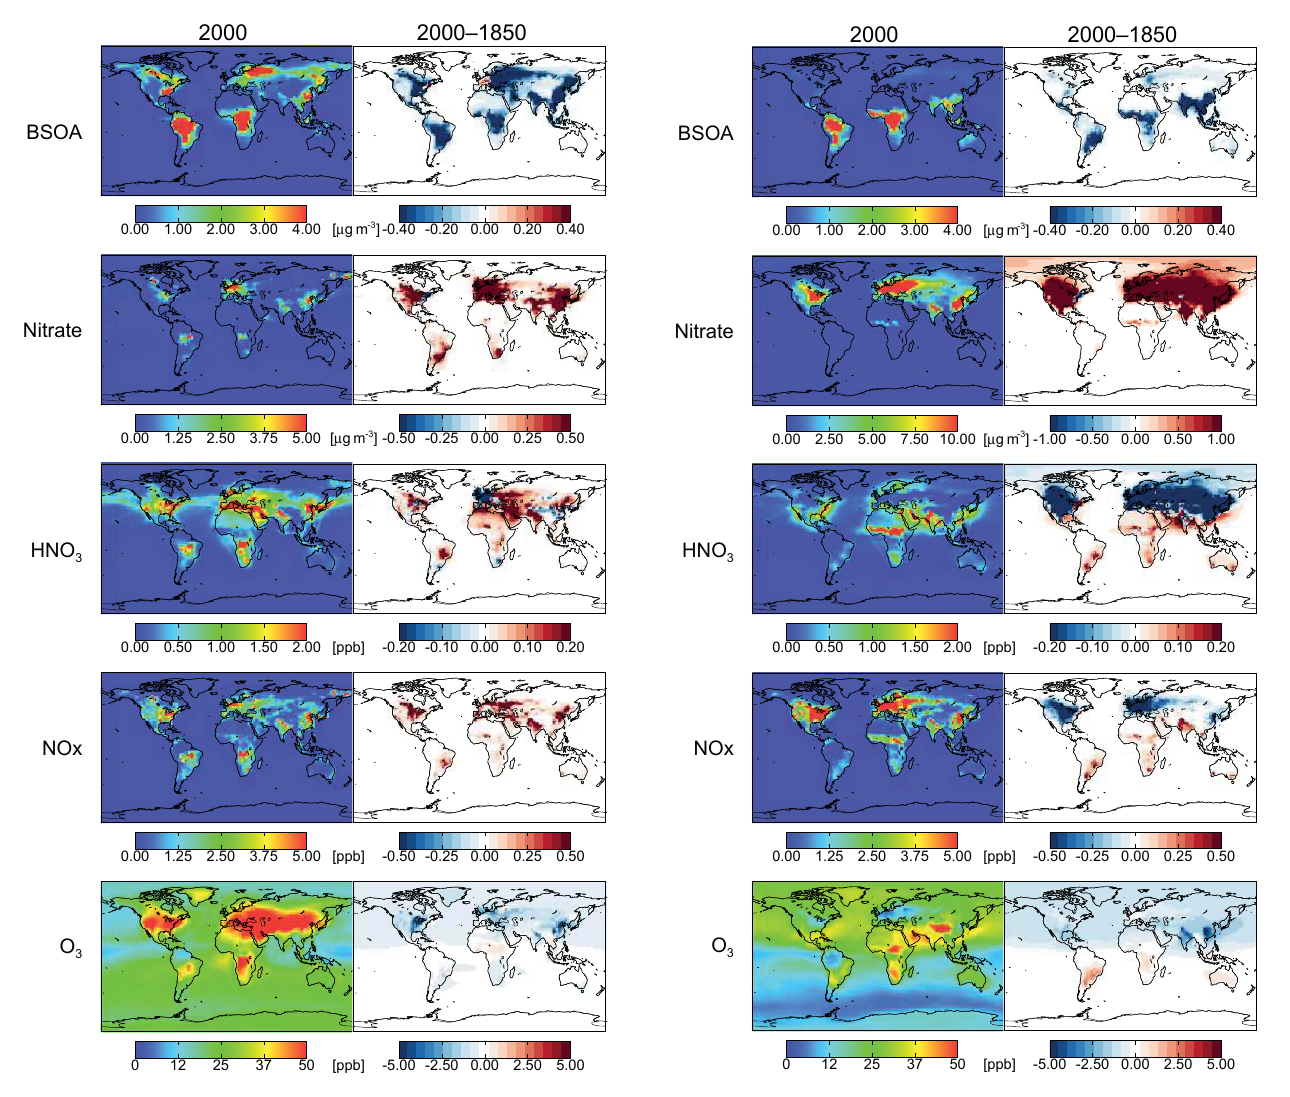
Figure 7. Boreal summertime (June–August) mean simulated sur- face concentrations of biogenic SOA (BSOA), aerosol nitrate, nitric acid (HNO 3 ) , nitrogen oxides (NO x ), and ozone. Concentrations for present day (2000) shown on the left; the change due to histori- cal land use change is shown on the right. All simulations performed with present-day (2000) anthropogenic emissions; shown here are the differences between simulations 1 and 7 (see Tables 1 and 2).